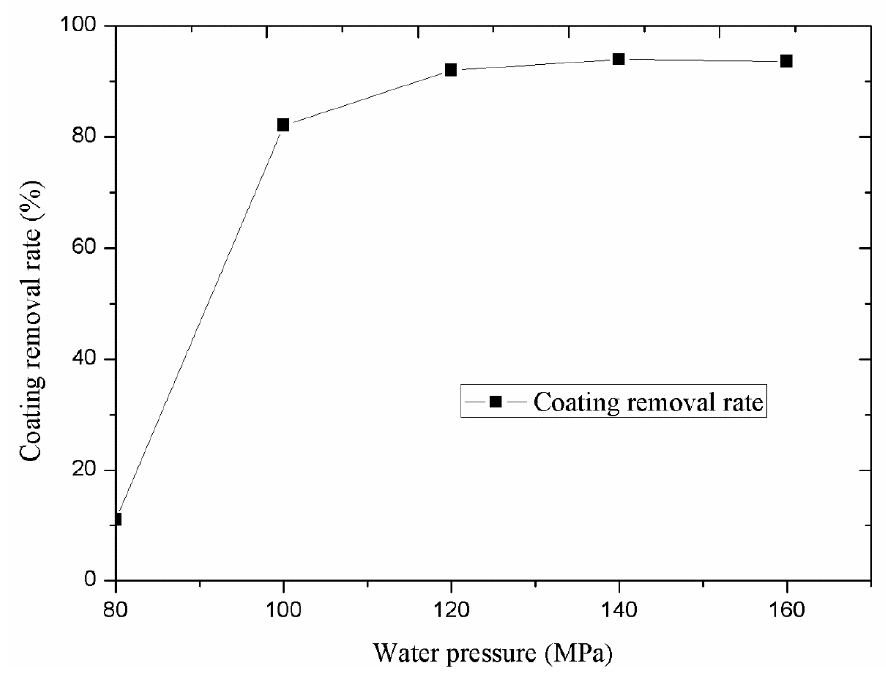
Figure 9. Coating removal rate for various water pressure levels.